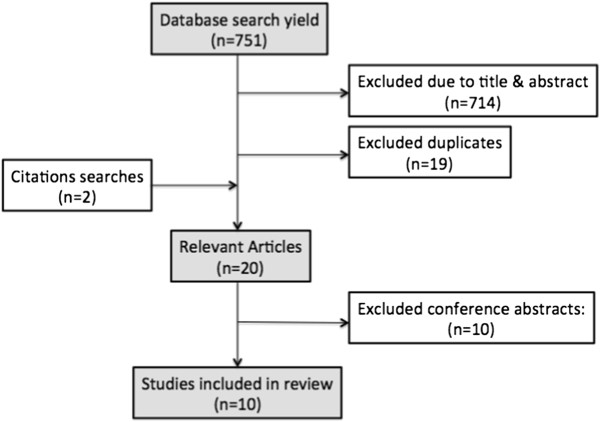
Flow diagram of search strategy.